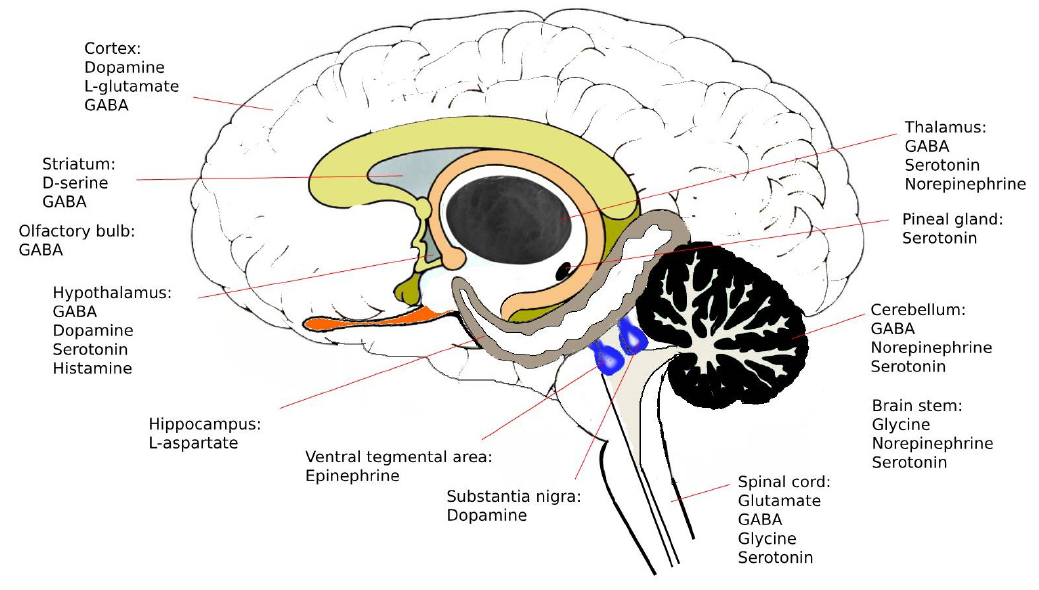
Figure 1. Regions of the brain where neurotransmitters are mainly